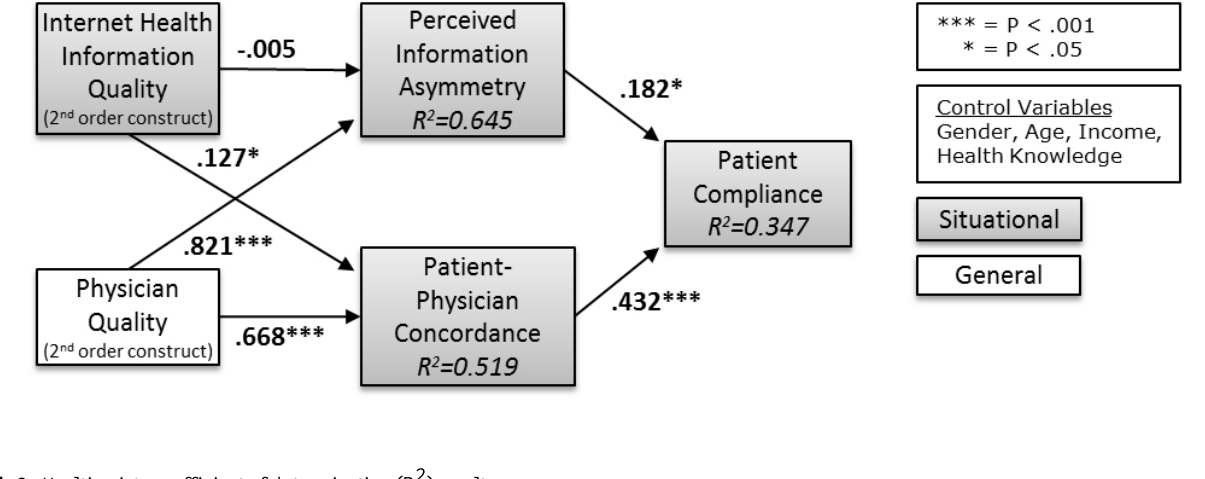
Figure 2. Partial least squares structural model results.